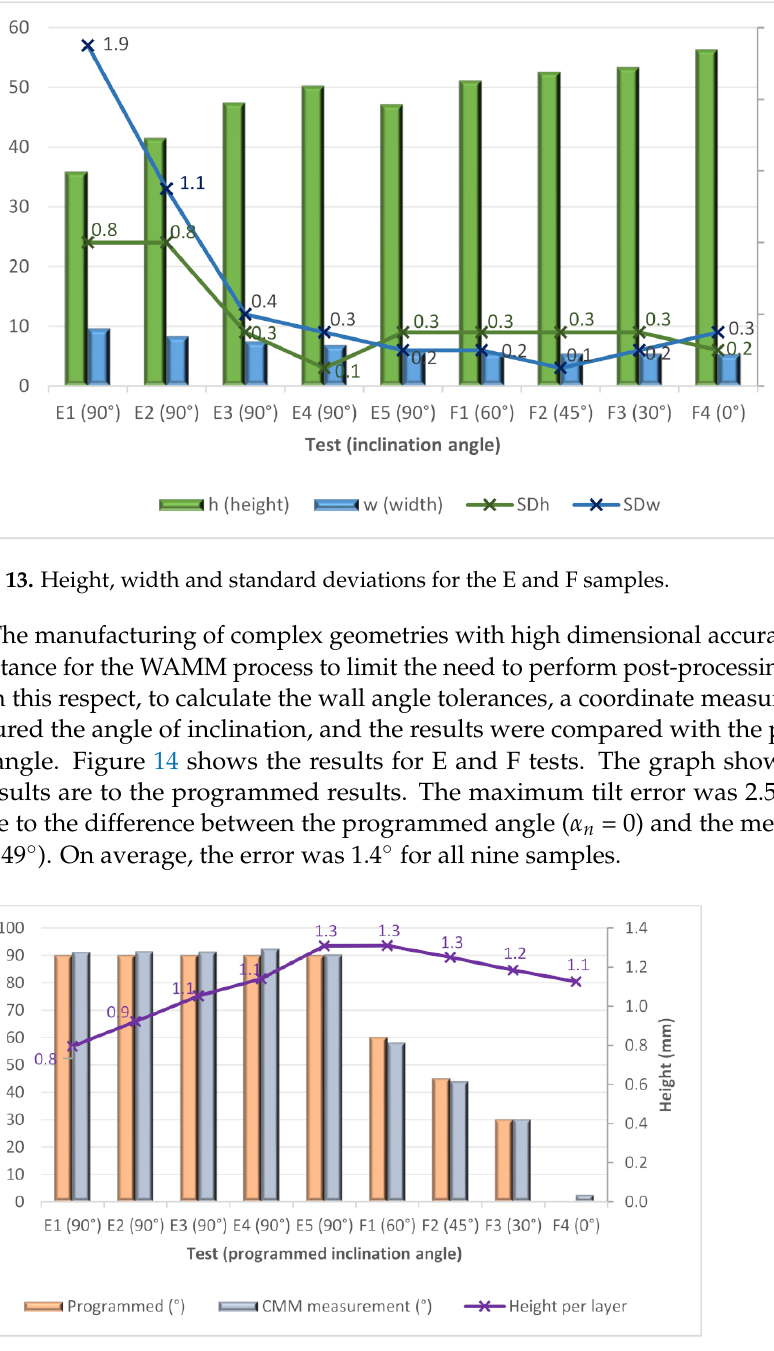
Figure 14. Measure angle, programmed angle and height per layer versus samples E and